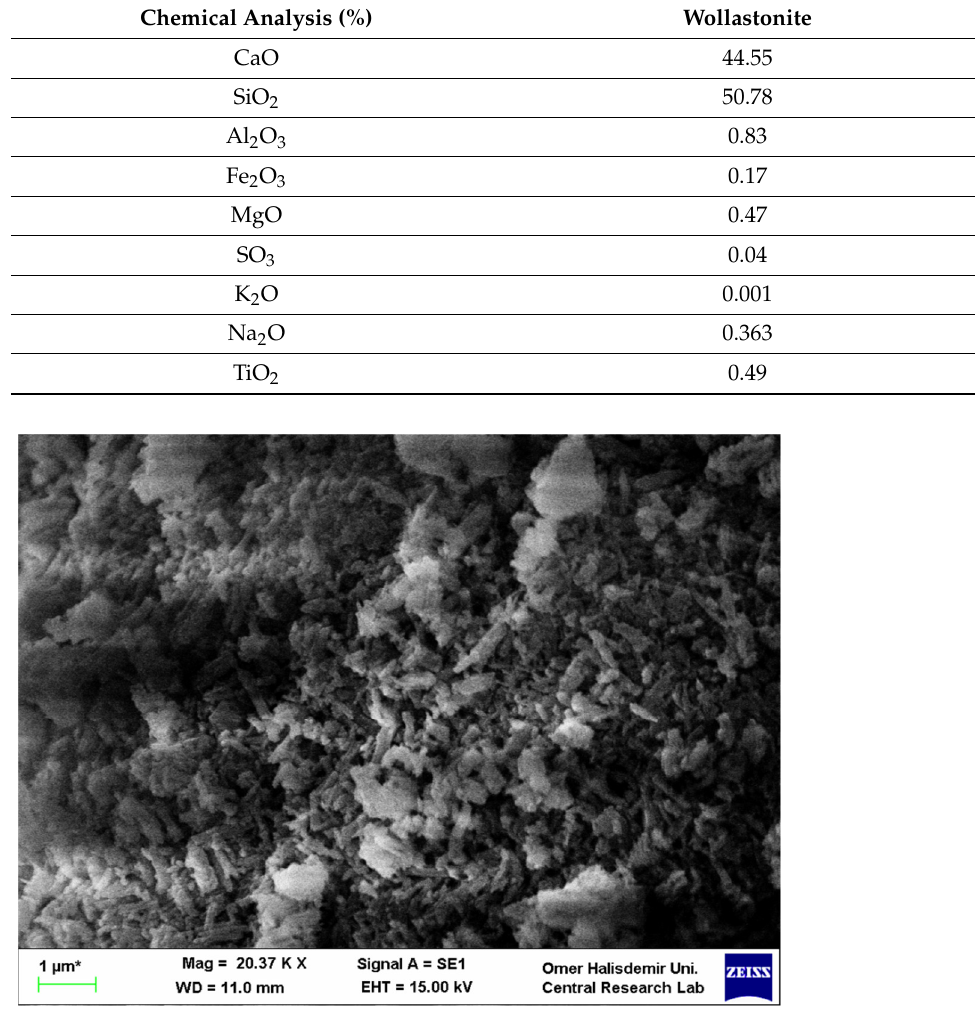
Table 1. Chemical composition of wollastonite based on Ref. [7].